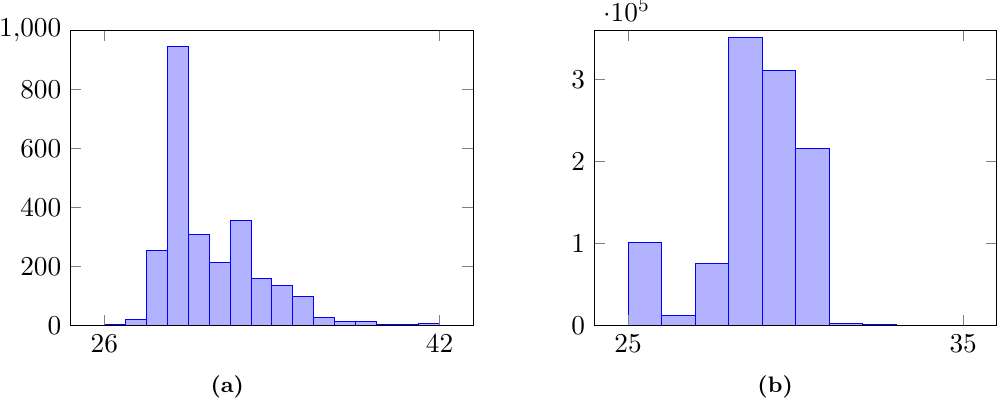
in 16 populations, containing 1000 Figure 1. a) Cumulative distribution of the charge Q flux D3 matrices each, after 72 hours of differential evolution. b) Charge distribution after applying the local Spider search to the output of the differential evolution. Both histograms include only flux matrices which give rise to a Minkowski minimum with full moduli stabilization on a smooth background (hence, all penalties described above are zero). Moreover, non-distinct flux configurations are counted as